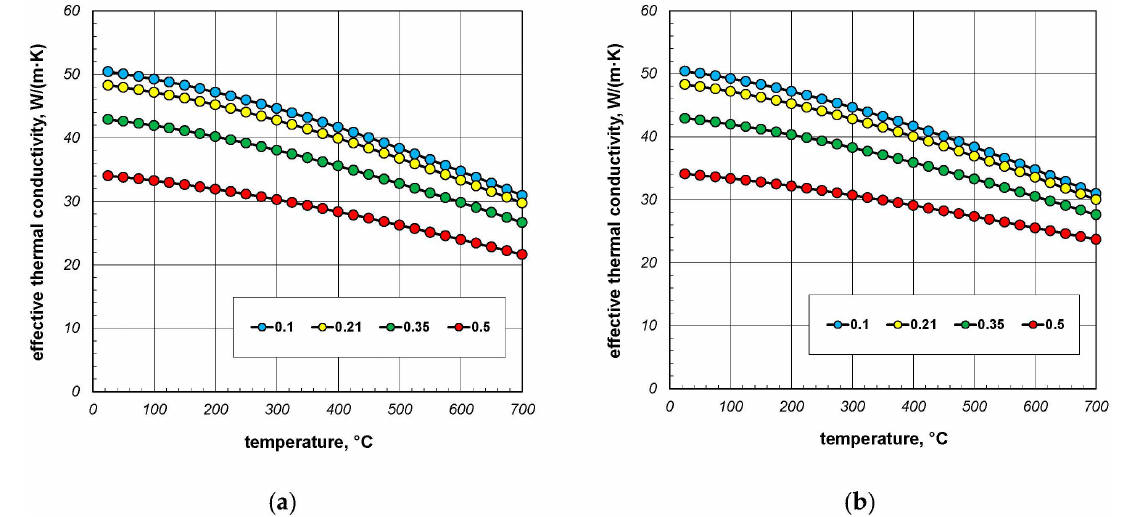
Figure 23. Calculated values of the effective thermal conductivity for a porous charge of a fibrous structure: ( a ) results for δ = 10 mm; ( b ) results for δ = 40 mm. The values visible in the key refer to the porosity of the charge.